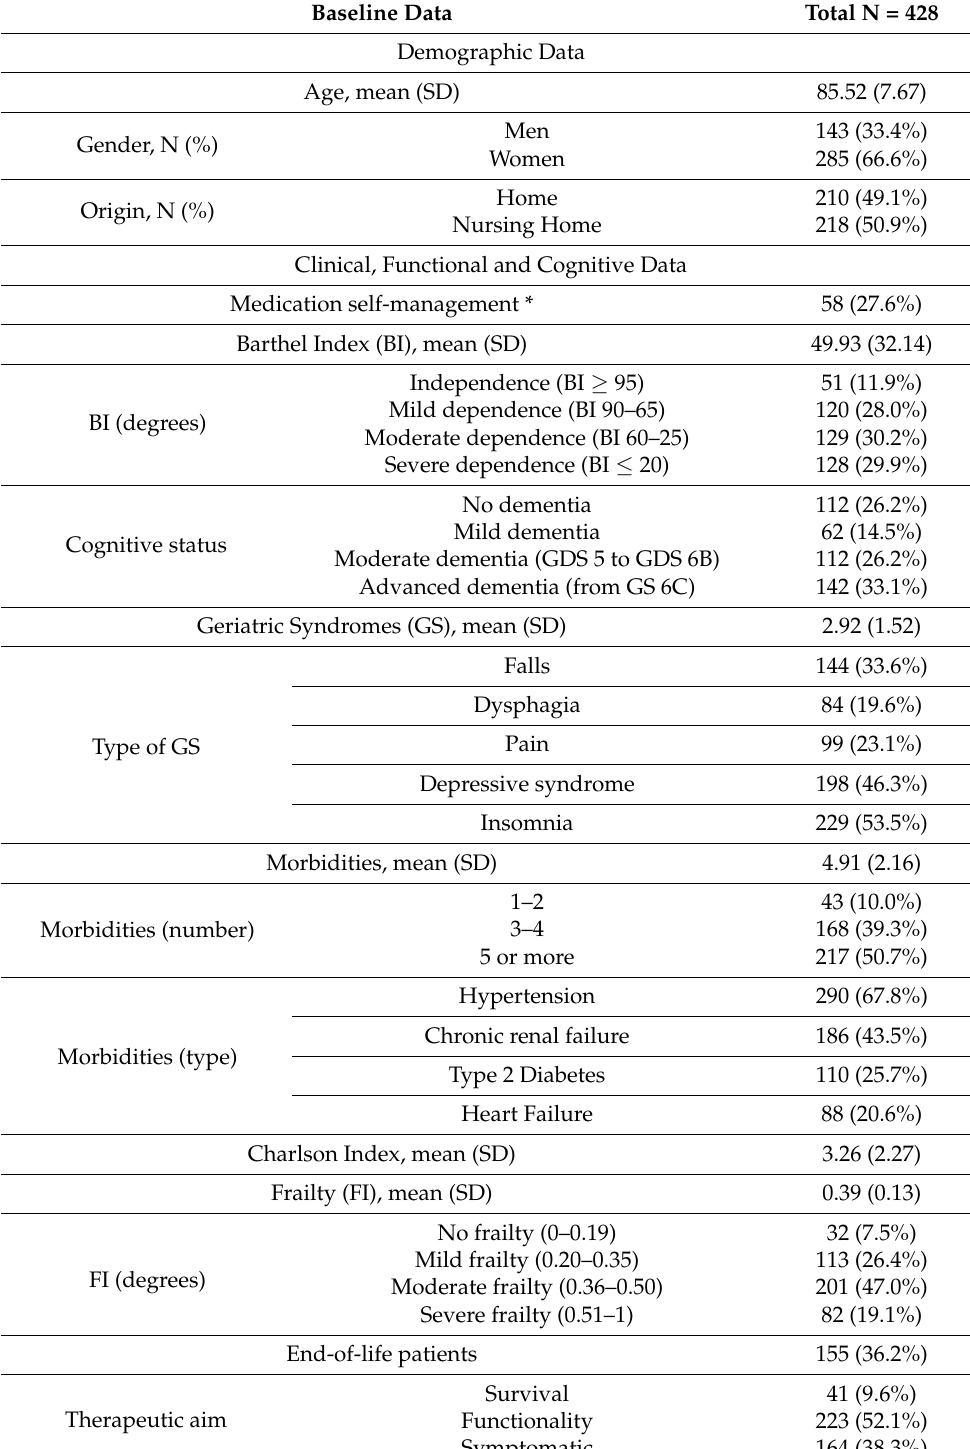
Table 2. COP-cohort’s baseline